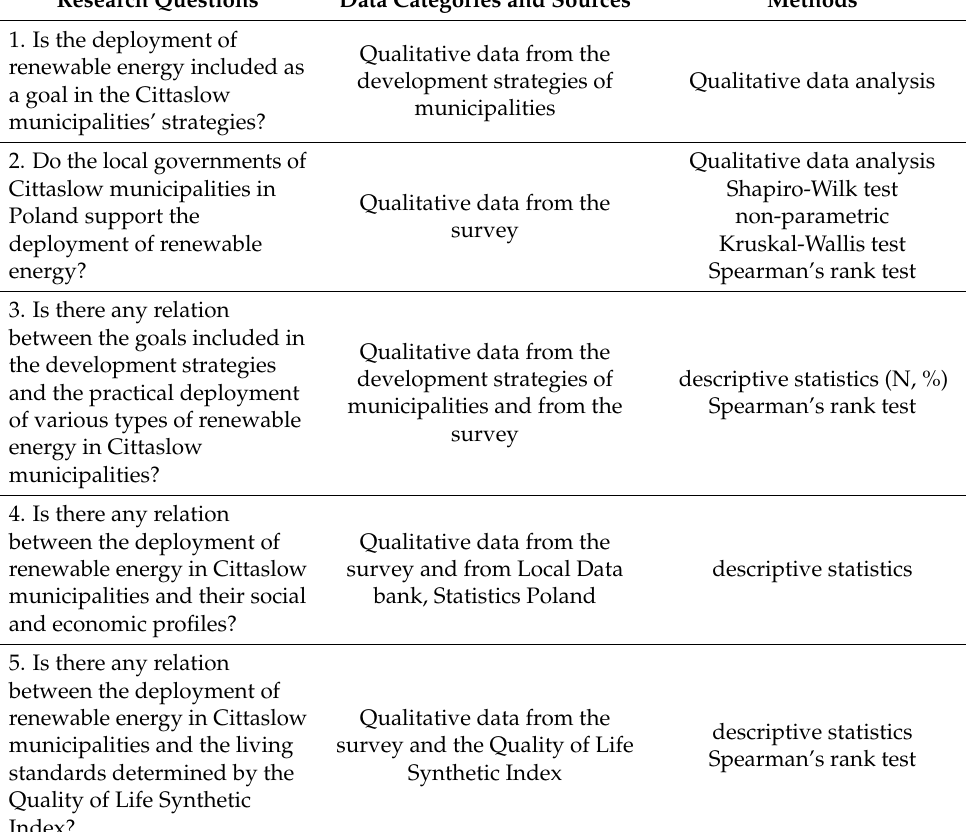
Table 1. Research questions and data categories, sources, and statistical